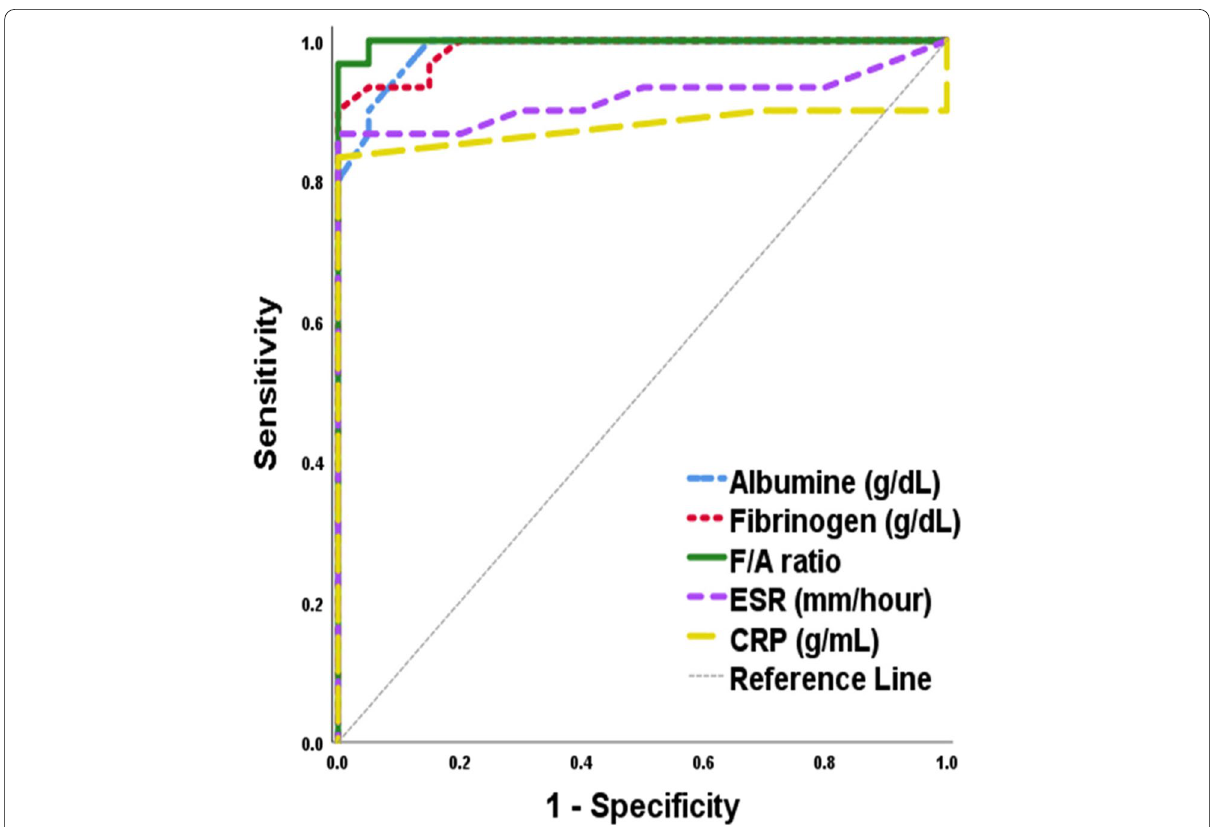
Fig. 1 ROC of albumin, fibrinogen, FAR, ESR, and CRP for discrimination between the AS and control groups